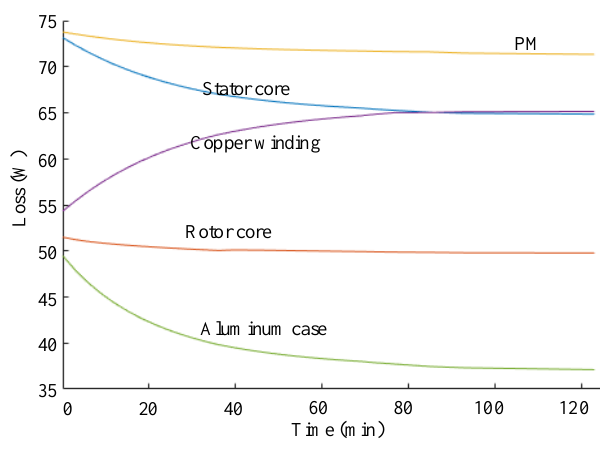
Figure 15. Results of EM losses.